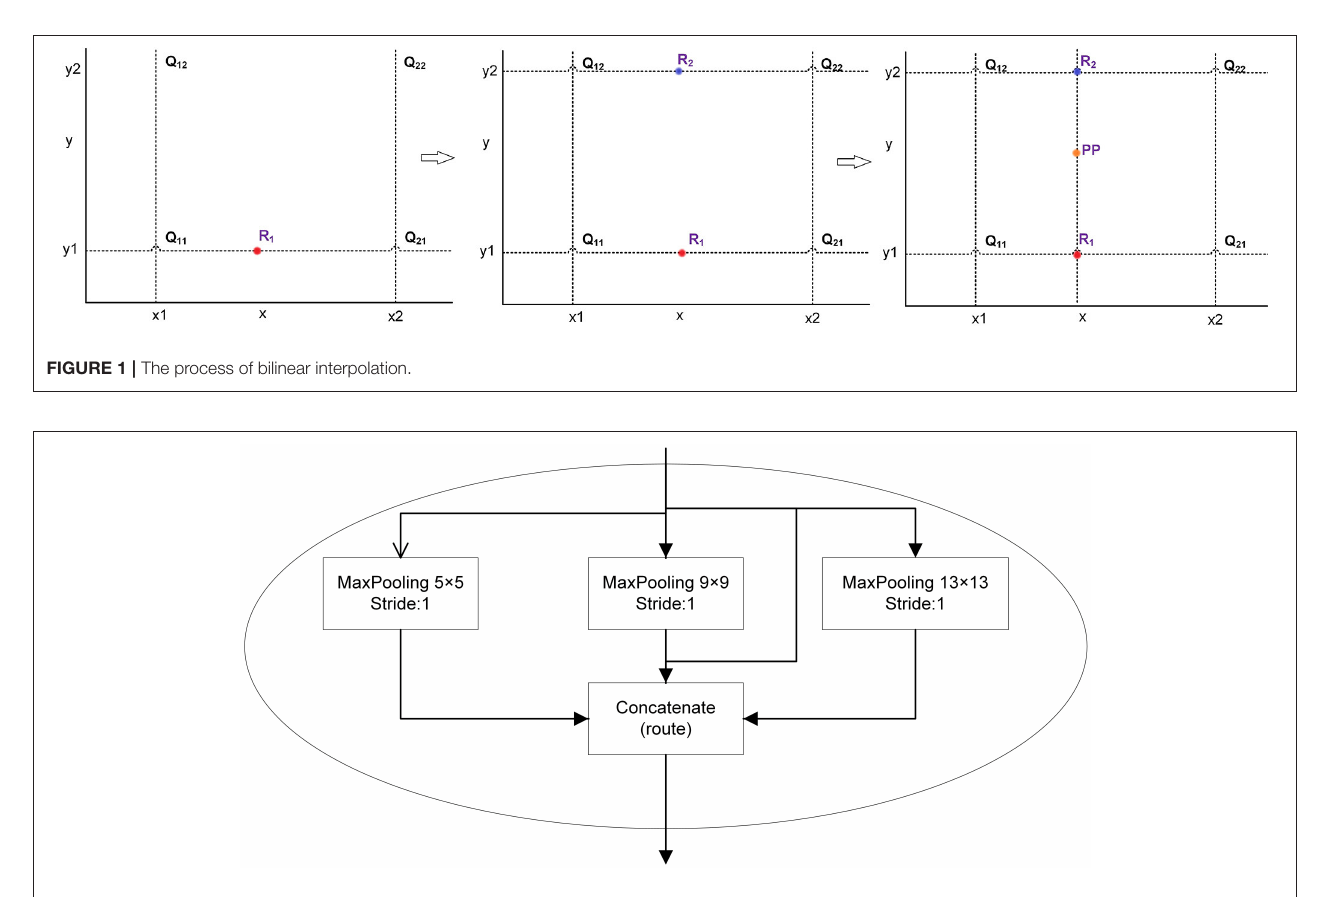
Frontiers in Plant Science |